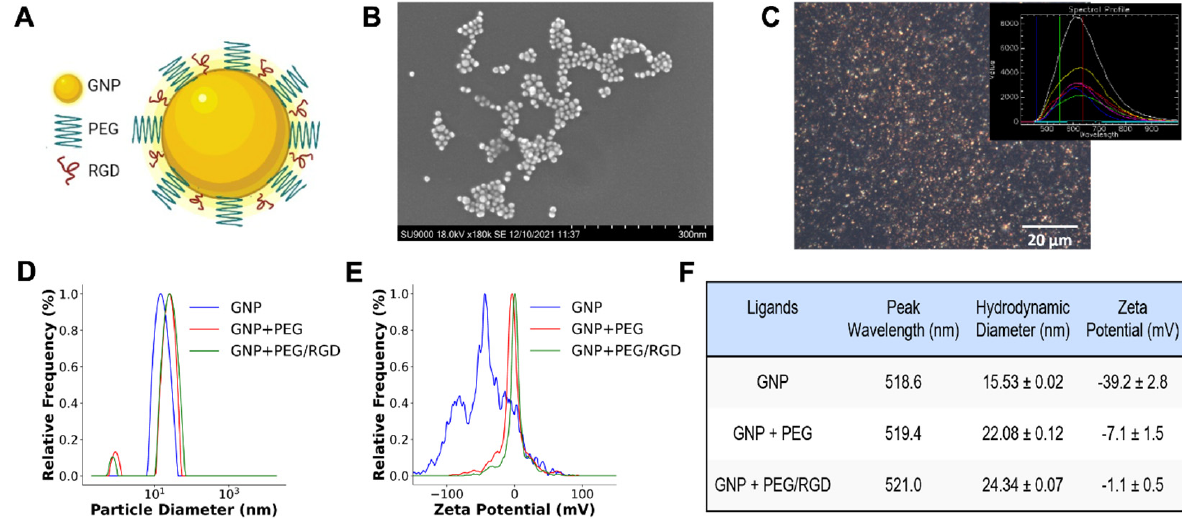
Figure 2. Characterization of GNPs. ( A ) Schematic diagram of GNPs functionalized with PEG and RGD peptide. ( B ) Transmission electron microscopy (TEM) image of GNPs. ( C ) Dark-field image of GNPs with inset figure displaying spectra collected using hyperspectral imaging. ( D , E ) Dynamic light scattering and zeta potential data for GNPs at each step of the functionalization process. ( F ) Summary of characterization data.